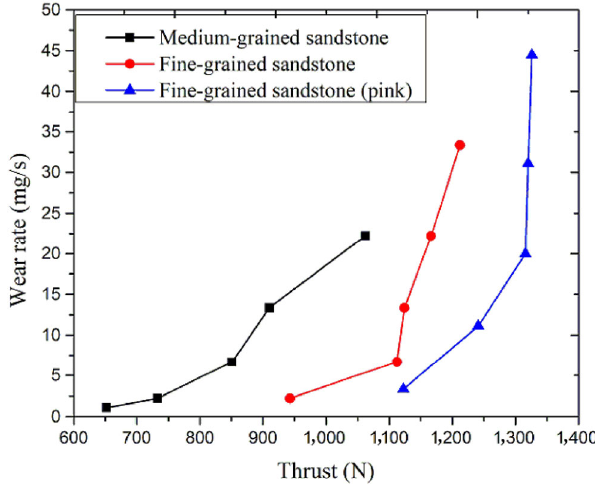
Fig. 5 Effect of thrust on wear rate of the drill bit.